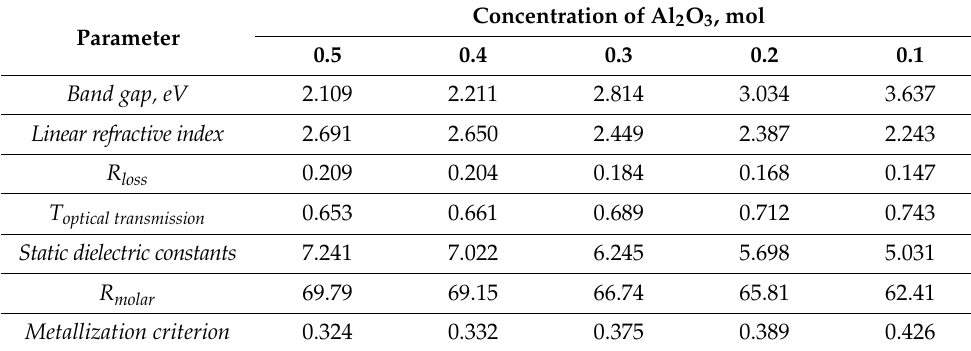
Table 1. Data on changes in optical characteristics.